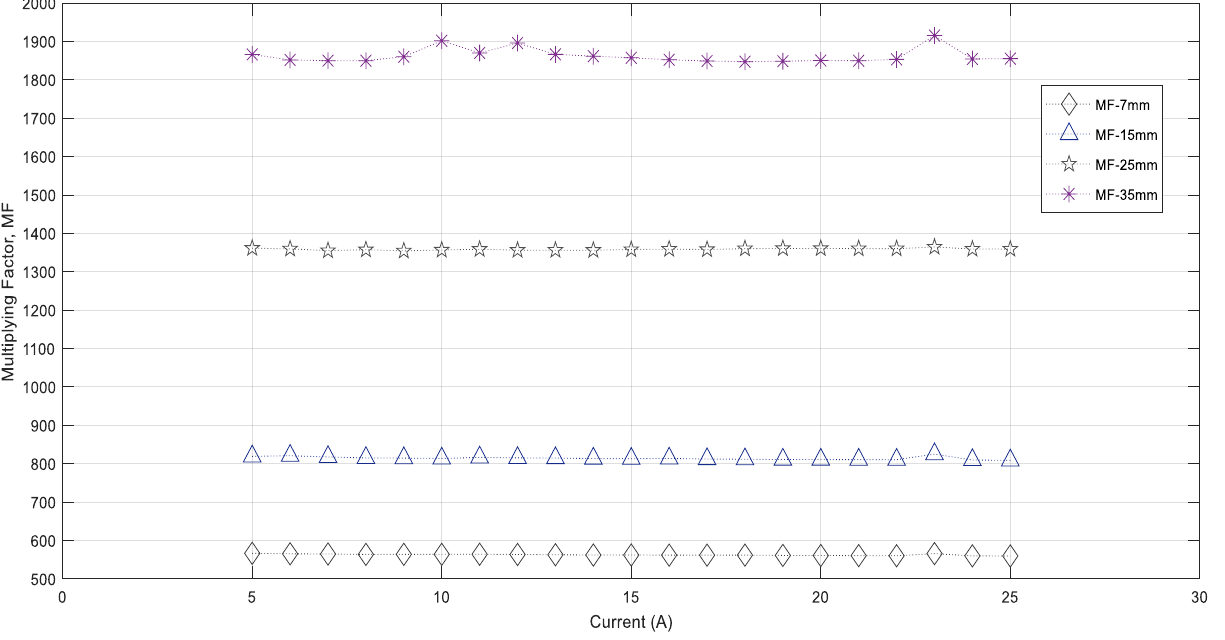
Figure 9. Multiplying factors for the sensor S3 for various distances.